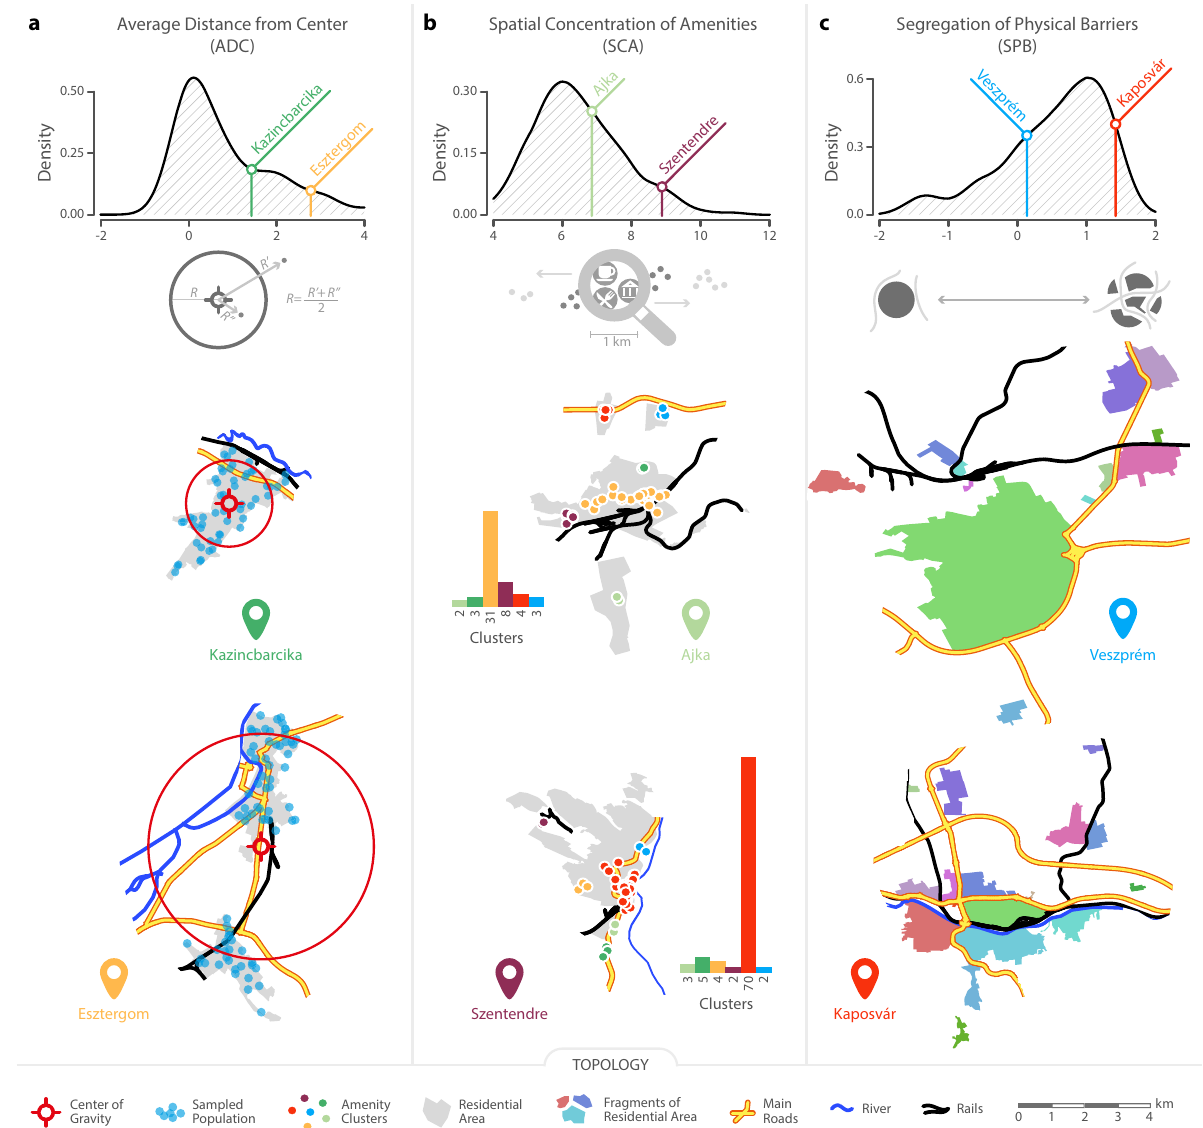
Fig. 2 Urban topology indicators. a ADC captures the average distance of neighborhoods from the center of gravity in the town measured in km and scaled by the size of town area. The two example towns both have around 30,000 inhabitants but Kazincbarcika (low ADC) is spatially concentrated while Esztergom (high ADC) has distant fragments of residential zones. b SCA measures the concentration of public and private services and amenities in spatial clusters, scaled by the size of town area. The two example towns have similar populations of around 30,000 inhabitants and both of six clusters of amenities. The difference between Ajka (low SCA) and Szentendre (high SCA) is that amenities are strongly concentrated in the largest cluster of Szentendre. c SPB quanti fi es the extent to which residential areas are divided by railways, roads, and rivers into disconnected components, indicated by colors. The two example towns both have around 60,000 inhabitants. Veszprém (low SPB) has a relatively compact structure with few distant residential zones and low degree of disconnection by physical barriers. On the contrary, neighborhoods of Kaposvár (high SPB) are cut into smaller areas by physical